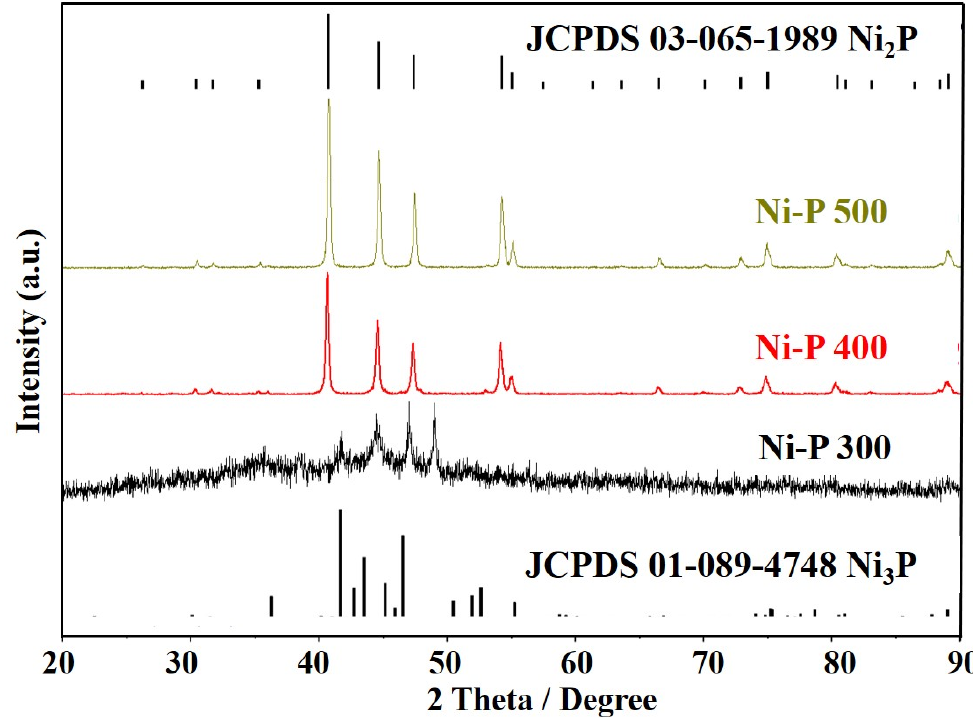
Figure 4. XRD diffraction patterns of Ni-P that crystallized upon different temperatures.